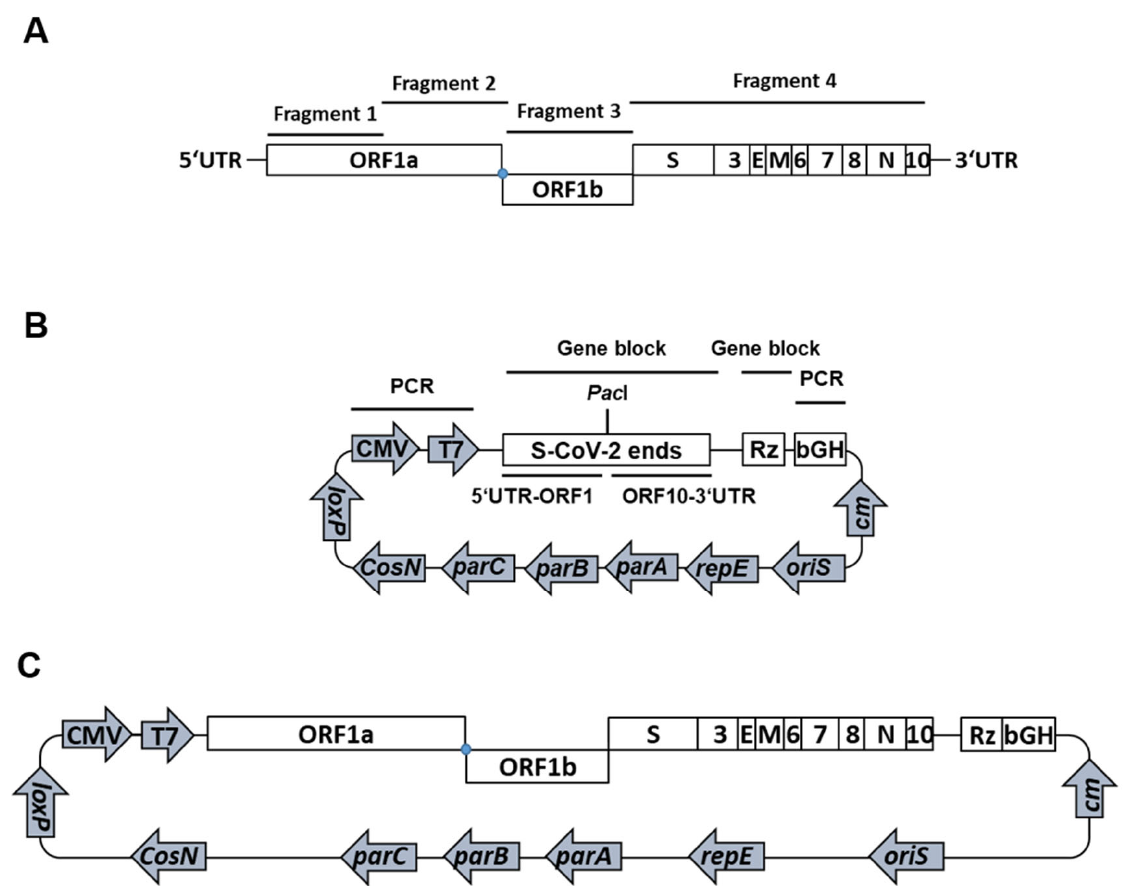
Figure 1. Cloning of a passage ‐ free SARS ‐ CoV ‐ 2 genome into a bacterial artificial chromosome (BAC). ( A ) Amplification of four overlapping fragments covering the entire SARS ‐ CoV ‐ 2 genome. The open reading frames (ORFs) and structural and accessory proteins are indicated. Extracted viral nucleic acids of a respiratory swab sample served as the template. The genome structure is not to scale. ( B ) Schematic depiction of the modified pBeloBAC11 backbone pBeloCoV. Human cytomegalovirus (CMV) and T7 RNA polymerase (T7) promoters, as well as the bovine growth hormone polyA tail (bGH), were amplified from pcDNA4 and cloned into pBeloBAC11 together with gene blocks encoding the 5 ′ and 3 ′ ends of the SARS ‐ CoV ‐ 2 genome with a flanking Pac I site and the hepatitis delta virus (HDV) ribozyme (Rz). ( C ) Schematic illustration of pBelo ‐ SARS ‐ CoV ‐ 2 (pBSCoV2). The four amplified fragments were assembled with the Pac I ‐ linearized pBeloCoV backbone.